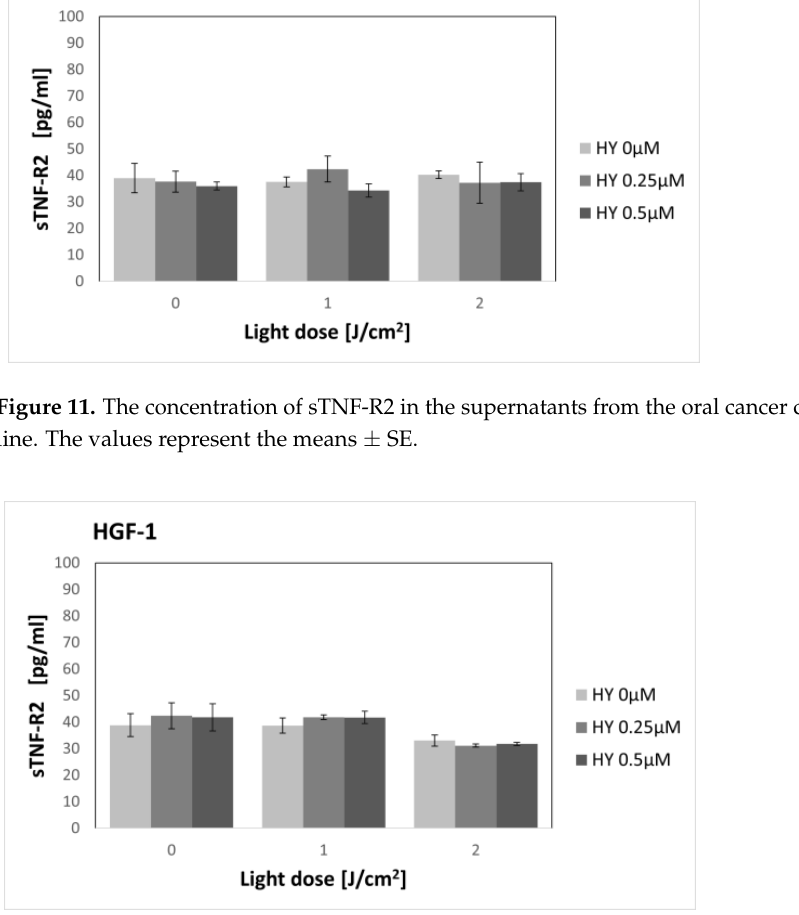
Figure 12. The concentration of sTNF-R2 in the supernatants from the gingival fibroblast HGF-1 line. The values represent the means ± SE.